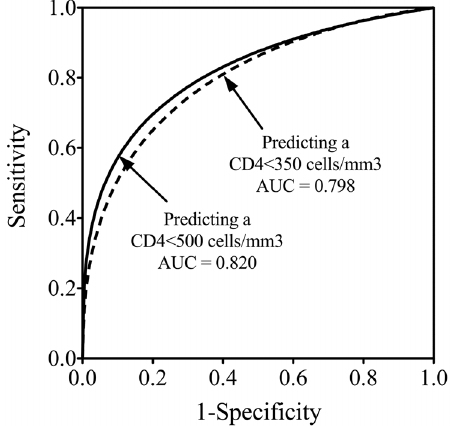
Figure 2. Receiver operating characteristic (ROC) curves for TLC thresholds predicting a CD4 cell count , 350 cells/mm 3 and a CD4 cell count , 500 cells/mm 3 . Areas under ROC curves (AUCs) were 0.80 and 0.82,